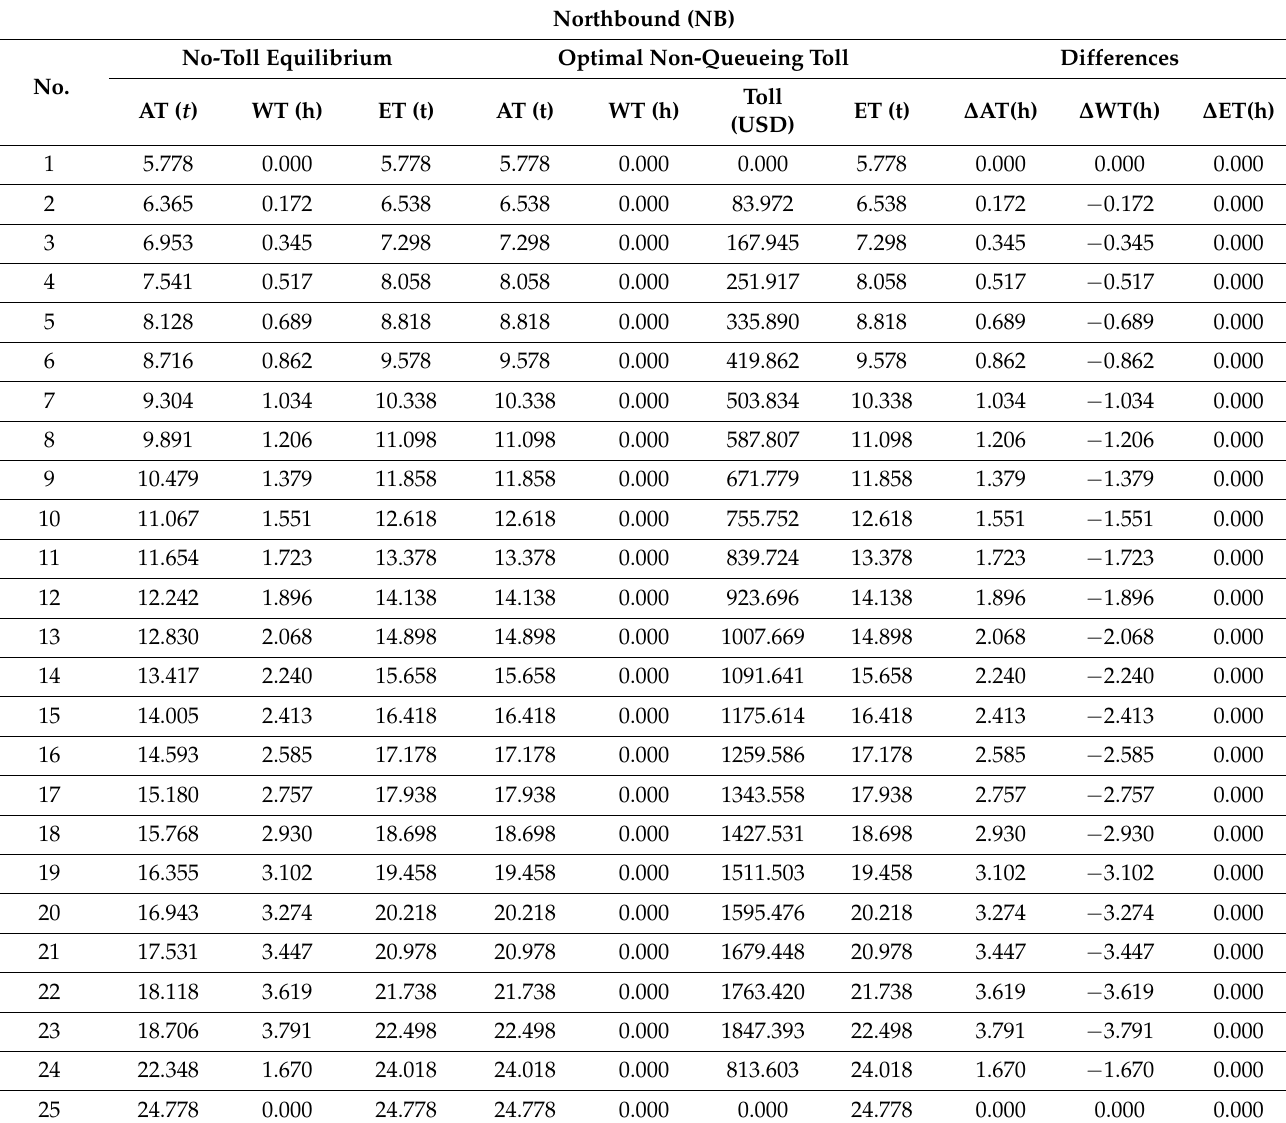
Table 10. Numerical results according to timetable for northbound ships from the no-toll to the tolled